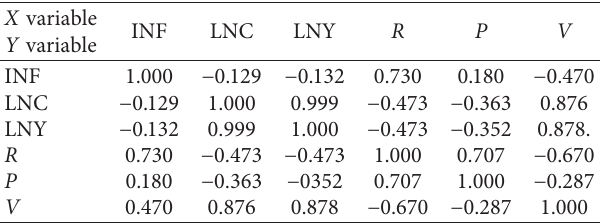
Table 10: The correlation coefficient matrix of the independent variables.